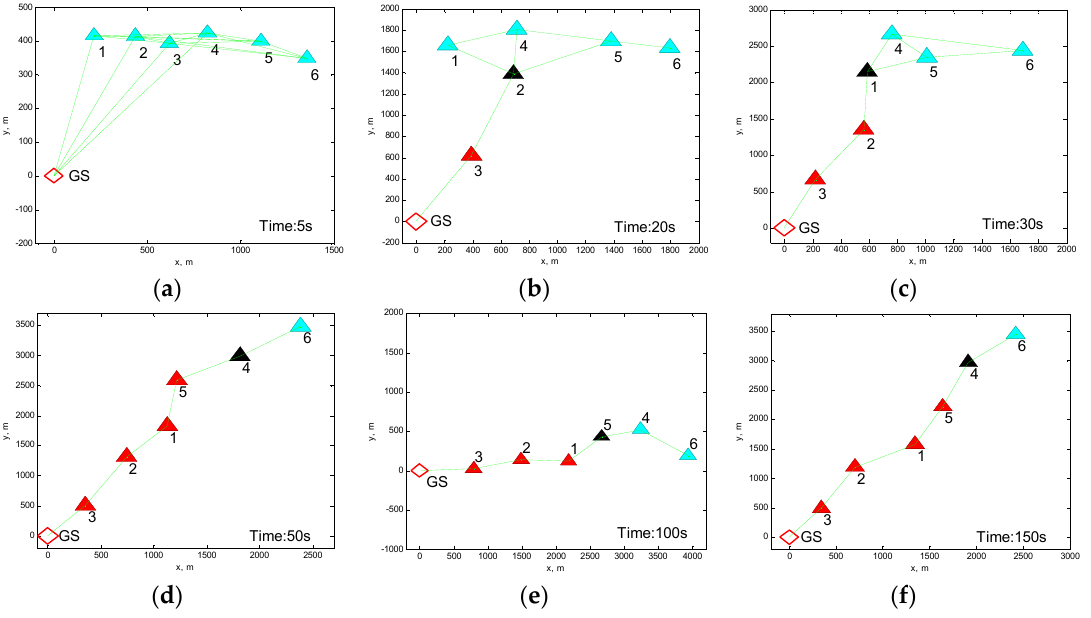
Figure 6. Network topologies in multiple UAVs cooperative surveillance at different instants: ( a ) 5 s; ( b ) 20 s; ( c ) 30 s; ( d ) 50 s; ( e ) 100 s; ( f ) 150 s. The red triangle means RUAV and the blank represents AUAV, and the remaining cyan one is SUAV.